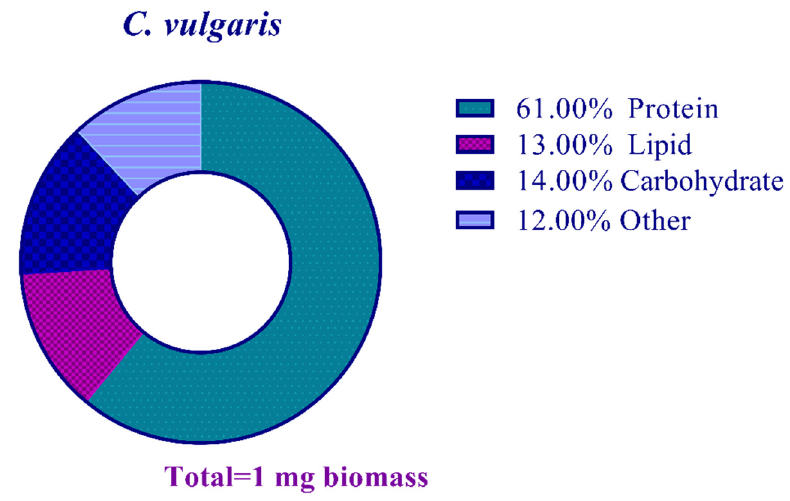
Figure 3. Biomass composition analysis of the studied C. vulgaris strain.